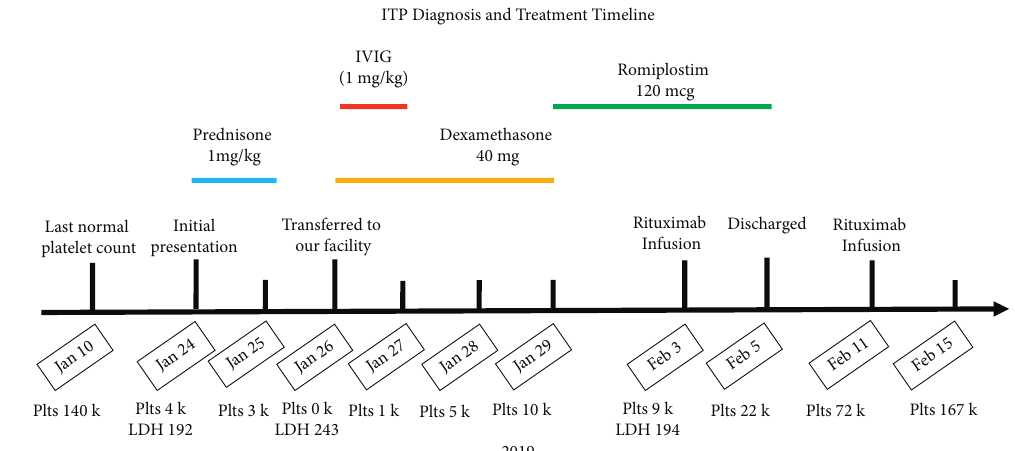
Figure 1: ITP diagnosis and treatment timeline. Major dates in the patient’s initial ITP presentation and treatment course occurring in 2019 are listed along the x -axis with accompanying hash marks and events above. Daily platelet counts (/ µ L) and LDH (U/L) where available are listed below respective dates. The above timeline includes major therapies with which the patient was treated, spanning across dates received including prednisone 1mg/kg (blue bar), IVIG (red bar), dexamethasone 40mg (yellow bar), and romiplostim 120 mcg (green bar). Overlapping bars imply multiple treatments given on same